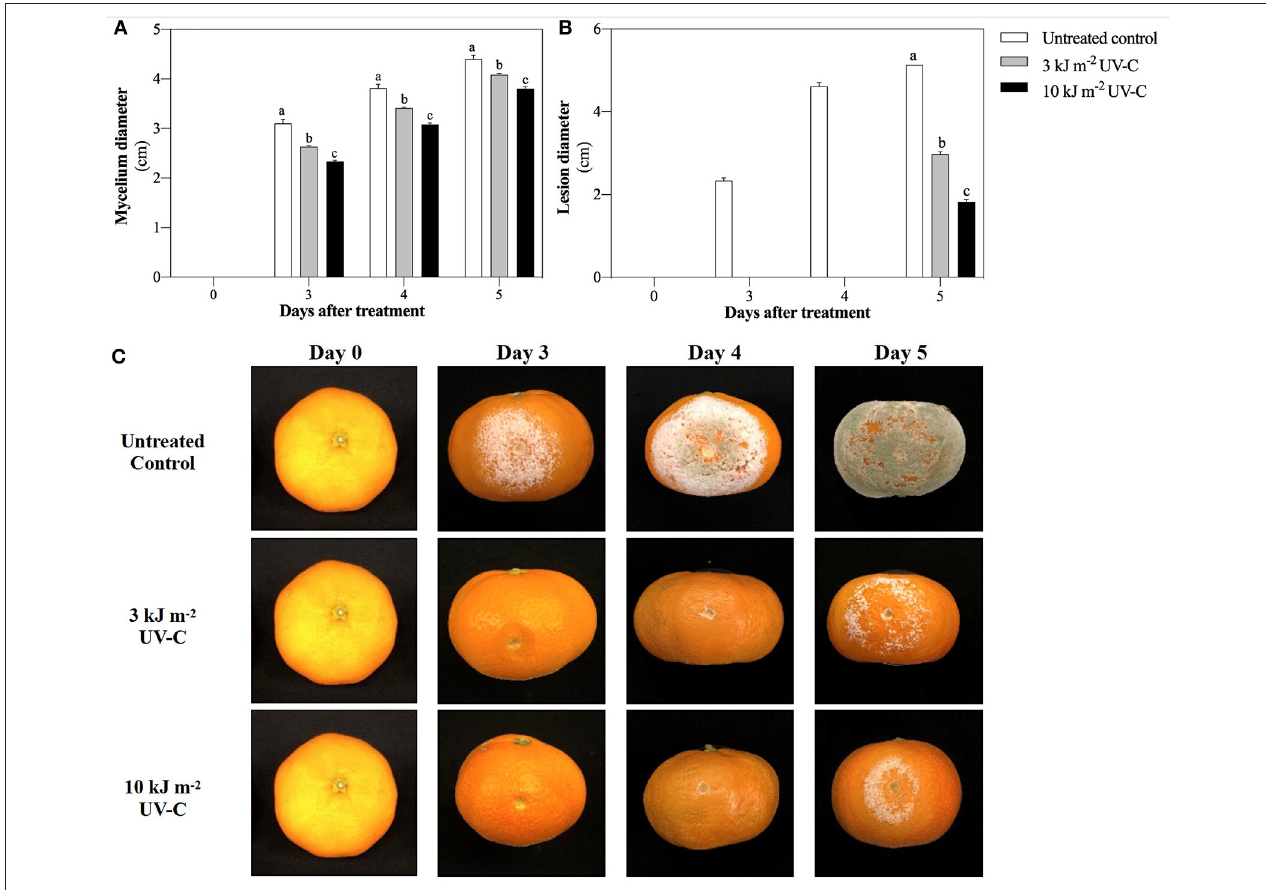
FIGURE 1 | Effect of UV-C treatment on suppression of P. digitatum growth in vitro study (A) , on inhibition of green mold decay development in satsuma mandarin fruit (B) , and visual appearance of inoculcated satsuma mandarin fruit after exposure to UV-C in untreated control, 3 kJ m − 2 , and 10 kJ m − 2 UV-C groups (C) . The different letters indicate significant differences at P ≤ 0.05 by LSD test at each day with the mean ± SE of three replications.